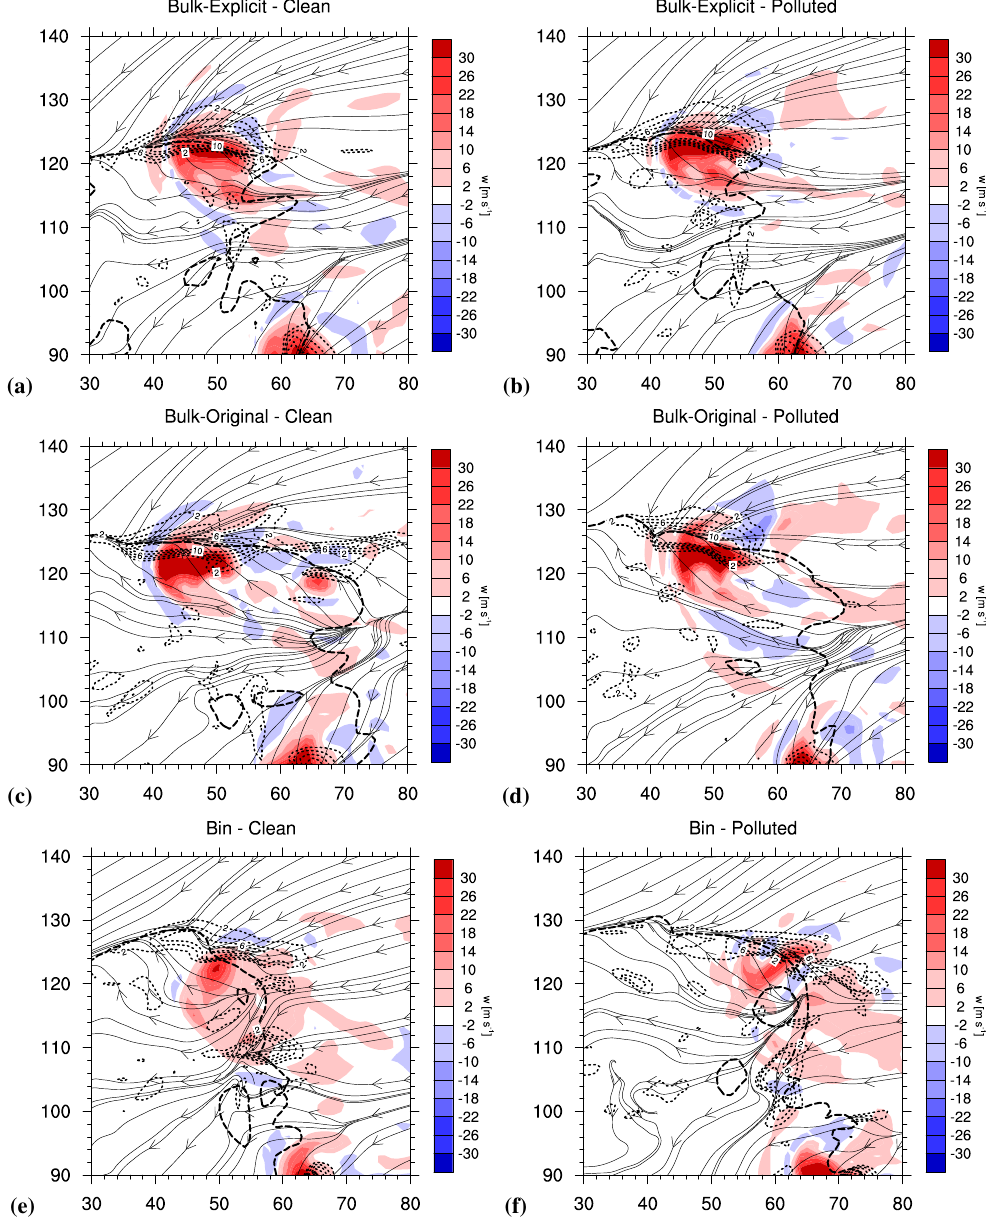
Fig. 14. Interaction between cold pool strength and convergence is shown. The cold pool boundary is demarcated by the dashed curve ( θ 0 < − 2K). Streamlines represent the flow at the lowest model level. Dotted contours depict the vertical velocity at 1.5km starting at 2ms − 1 and stepping by 2ms − 1 , while the filled contours (color bar) show the vertical velocity at 9.1km. The “Polluted” (b, d, f) and “Clean” (a, c, e) scenarios are shown for the bulk-explicit (a, b) , bulk-original (c, d) , and bin (e, f) model configurations at 90 min.